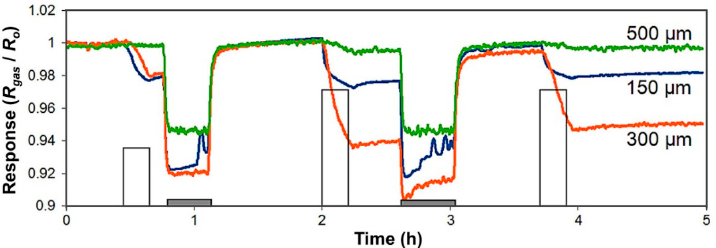
Figure 5. Room temperature detection of NO 2 for sensors with different CNT lengths. White pulses indicate the exposure to 0.5 ppm, 1 ppm, and 1 ppm of NO 2 (duration: 15 min). Gray bars indicate the periods of heating at 150 °C that help clean the surface of CNT after being exposed to NO 2 . Heat was not applied after the last exposure cycle, and the baseline was not regained [90]. Ada Fort et al. developed sensors based on CNTs decorated with gold nanoparticles and TiO 2 , which were operated at temperatures below 250 °C. CNTs decorated with na- noparticles showed more activity at low temperatures than pristine CNTs, thus enabling high sensitivity for CNTs decorated with gold nanoparticles with a value of 10% at 12 ppm NO 2 operating at 240 °C [93]. Dilonardo et al. developed sensors based on CNTs with metallic nanoparticles of Au and Pd deposited on its surface. Sensing tests were carried out at different concentrations of NO 2 operating at different temperatures (45–200 °C) [38]. Metallic nanoparticles were deposited into CNTs using the electrophoresis technique; these sensors obtained high gas sensitivity, fast response, and low limit of detection, as shown in Figure 6. Using the same strategy, the Pt nanoparticles were supported into